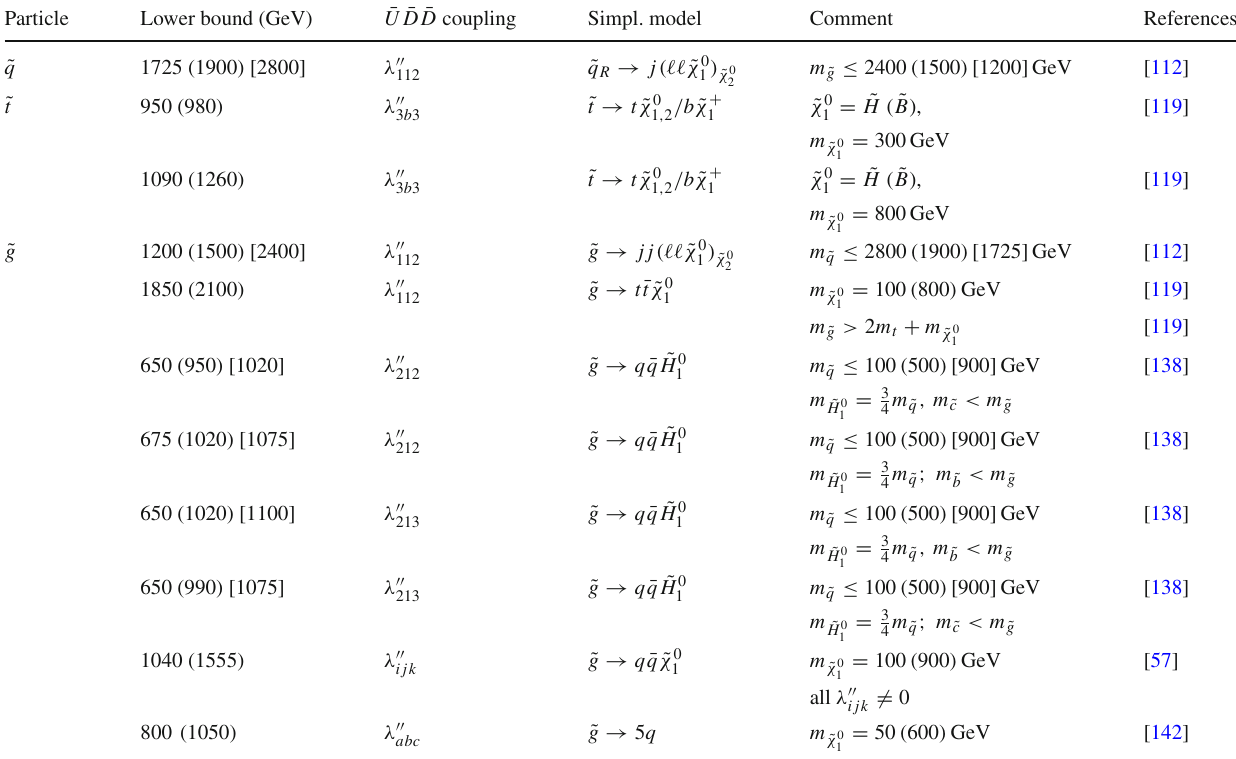
otherwise. The bounds are only estimates, as they have been read off the relevantplots.TheneutralinoLSPalwaysdecaysas ˜ χ 0 for ¯ U i ¯ D j ¯ D k . Each mass bound is for a fixed value of the RPV coupling